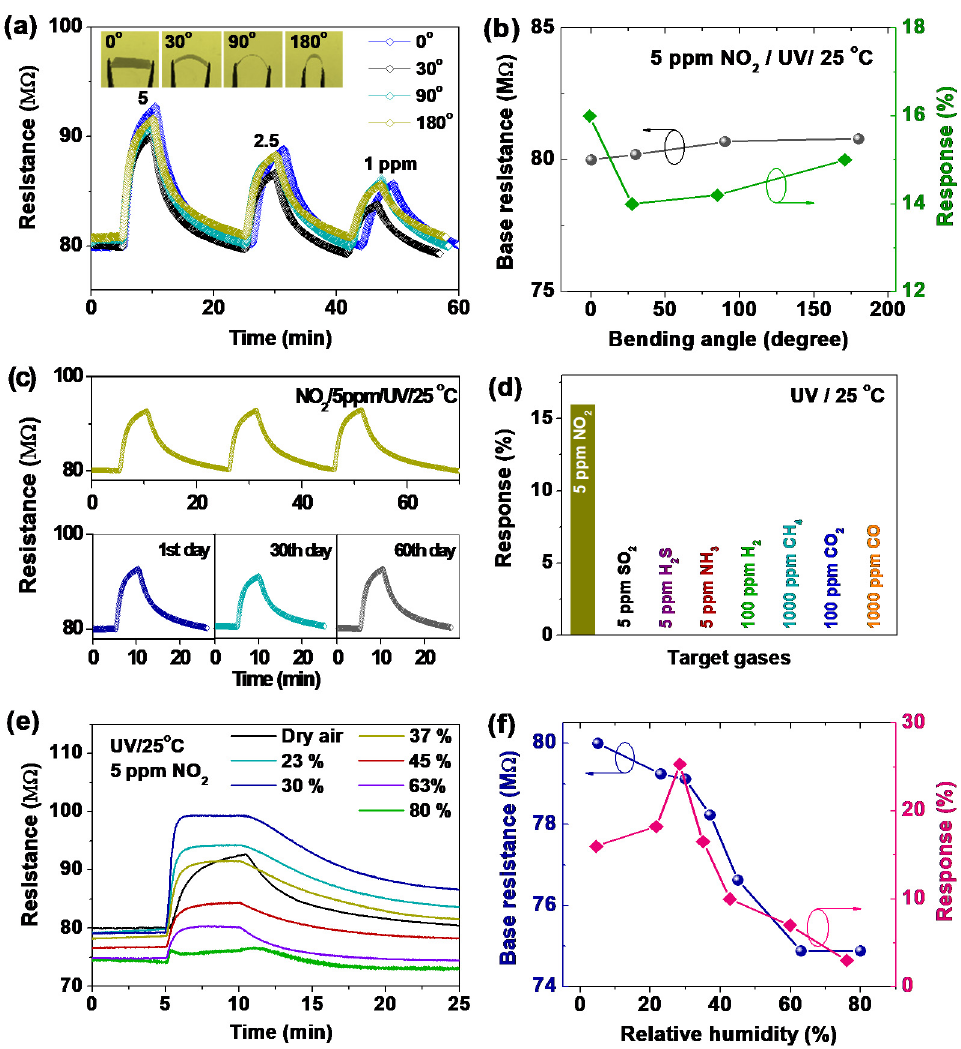
Figure 9. ( a ) Real-time resistance curves of SnS-80-H300 recorded under different NO 2 concentrations and with different bending angles. ( b ) Effect of bending angle on the base resistance and response of the sensors derived from (a). ( c ) Short-term stability of the SnS-80-H300 sensor over three cycles (top) and corresponding long-term stability (bottom) of the SnS-80-H300 toward 5 ppm NO 2 measured over 60 days. ( d ) Relative responses of SnS-80-H300 to various target gases showing the high selectivity of the sensor toward NO 2 . ( e ) Real-time response of the SnS-80-H300 sensor to 5 ppm NO 2 under different RH conditions. ( f ) Effect of RH on the base resistance and response of the sensor. All gas-sensing measurements were conducted under UV illumination at RT (25 °C).